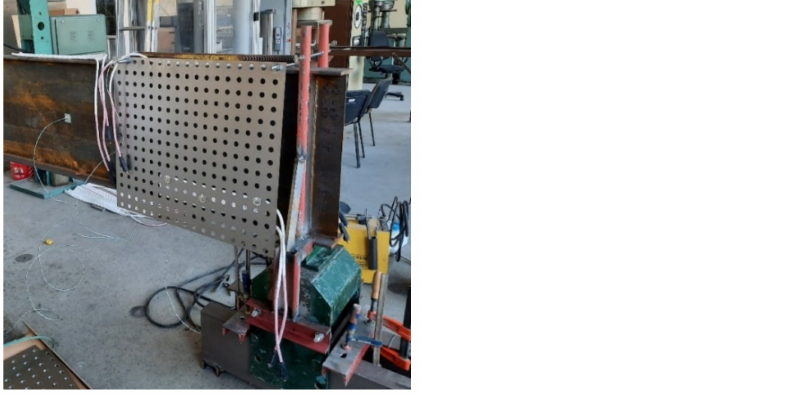
Figure 5. Beam B1 during application of thermocouples and ceramic heating pads.